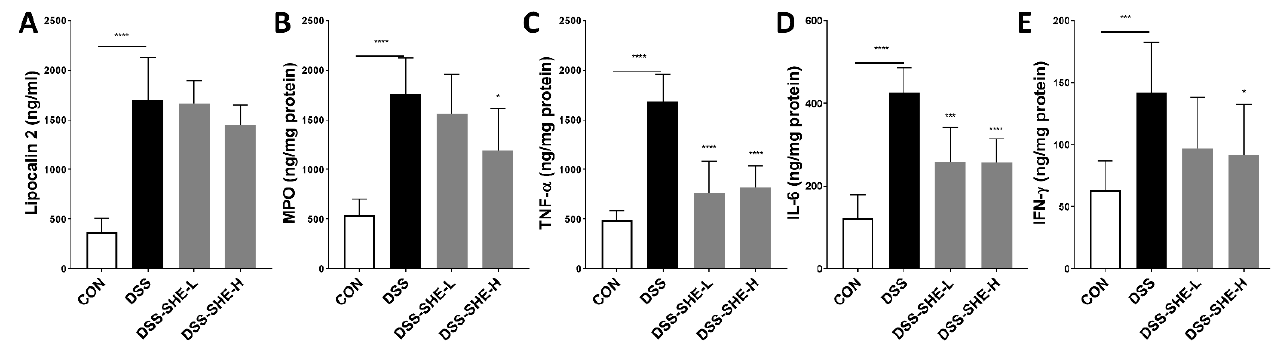
Figure 5. Effects of S. horneri extract (SHE) on levels of inflammatory markers in DSS-treated mice. ( A ) Lipocalin-2 in serum, ( B ) myeloperoxidase (MPO), ( C ) TNF- α , ( D ) IL-6, ( E ) IFN- γ levels in the colons of mice were measured by ELISA. All data are expressed as means ± SD ( n = 8). * p < 0.05, *** p < 0.001, **** p < 0.0001, significantly different compared with DSS group by one way ANOVA followed by Dunnett’s test. CON: control group; DSS: 2.5% DSS in drinking water for the last 7 days; DSS-SHE-L: DSS + S. horneri extract low dose group (100 mg/kg bw/day); DSS-SHE-H: DSS + S. horneri extract high dose group (200 mg/kg bw/day).